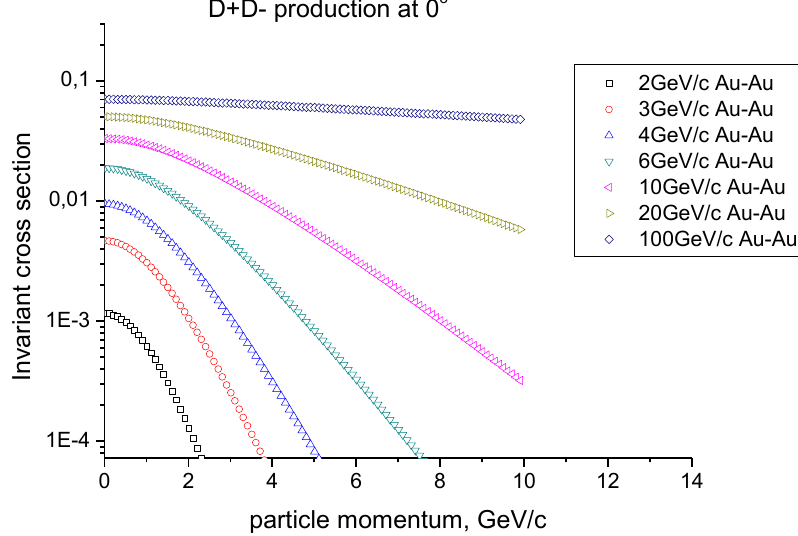
Figure 2. D meson production at zero angle in Au-Au collisions for different collision energies (invariant cross section in mb·GeV -2 ·c 3 ·sr -1